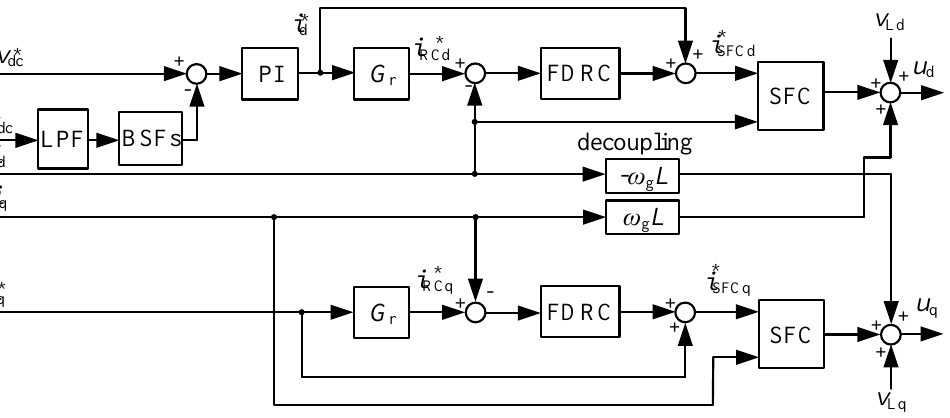
Figure 10. Scheme of the grid-tied converter feedback control system with FDRCs and